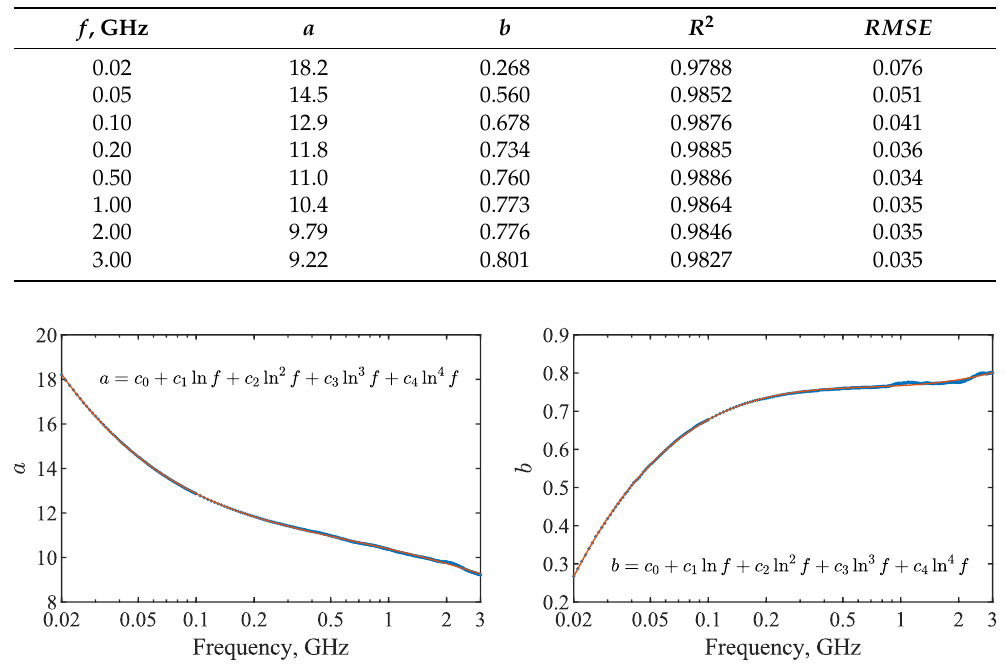
√ Figure 3. Slope a and intercept b (blue dots) of the ε (cid:48) ( θ ) relation (Equation (2)) as functions of frequency. The frequency dependencies of the a and b parameters were modeled by a fourth-order polynomial (red lines) with respect to the natural logarithm of the frequency f expressed in GHz, according to Equation (3). Table 2. Coefficients: c 0 , c 1 , c 2 , c 3 and c 4 , with their standard errors SE , t -statistics and p -values, of Equation (3) fitted to the frequency dependence relations of the a and b parameters of Equation (2) for frequency expressed in